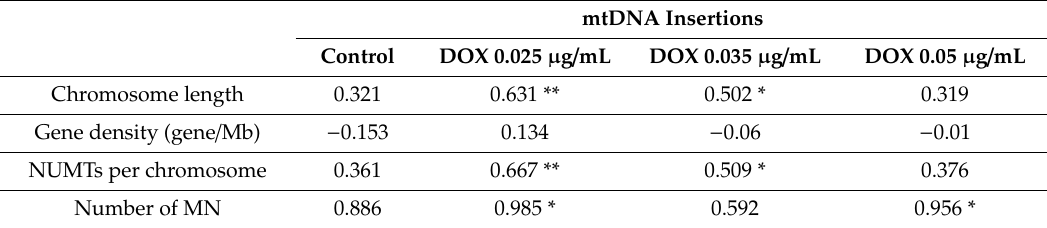
Table 2. Pearson correlation coe ffi cient (r) of DOX-induced mtDNA insertions in human chromosomes with chromosome length, gene density, NUMTs per chromosome and MN